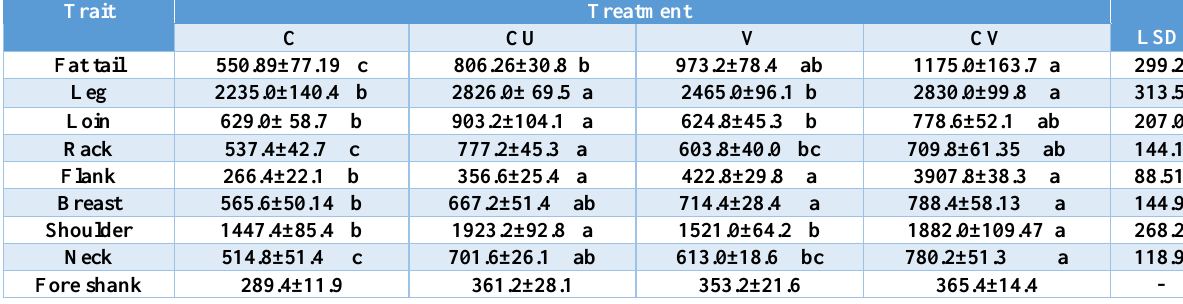
Table, 7: Effects of vasectomy and/or adding Cuminum cyminum in the diet on the weights & the ratio of the rib region component of Awassi male lambs (Mean±SE).